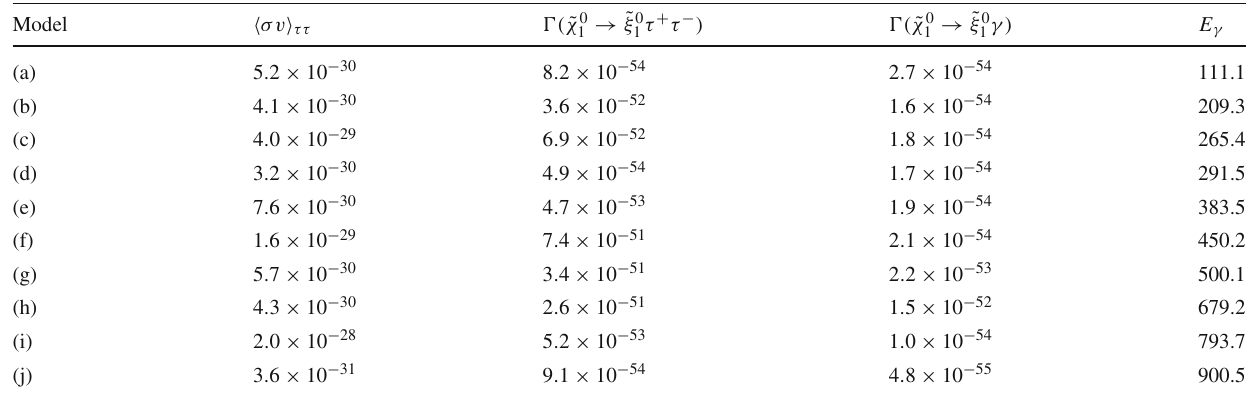
Table 3 For the benchmarks of Table 1, a display of the DM anni- hilation cross-section, the radiative decay width and three-body decay width of ˜ χ 0 and the attendant photon energy E γ . The decay width and 1